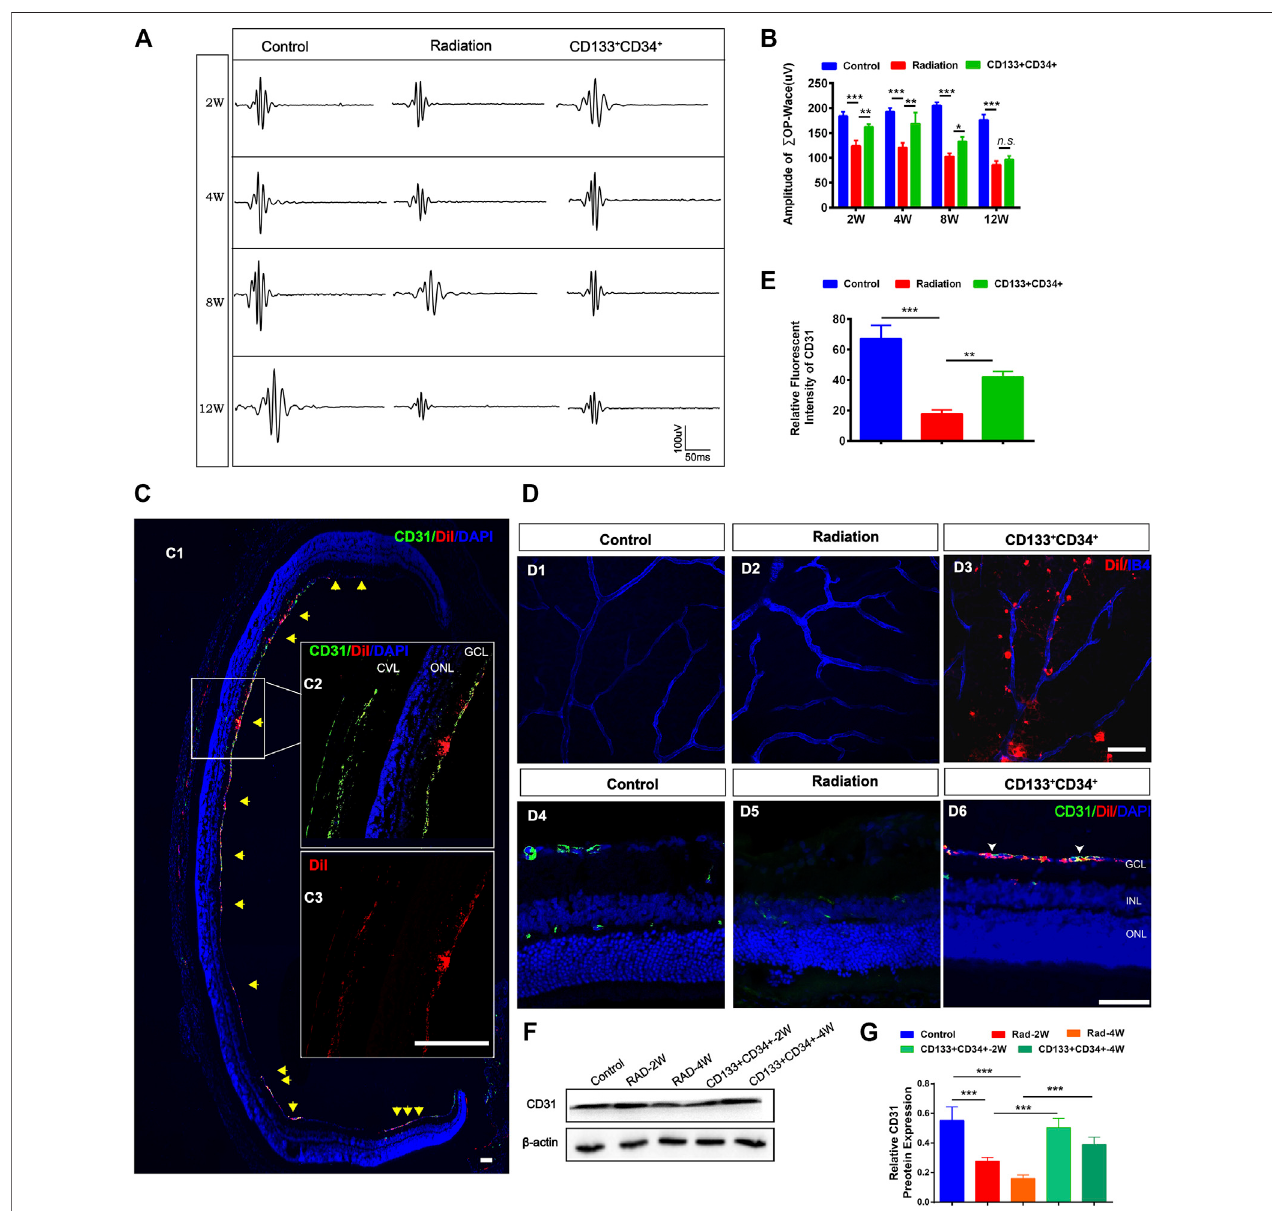
FIGURE4| TransplantedCD133 + CD34 + cellsprotectretinalvasculatureinjuriesafterradiation. (A) :RepresentativeimagesofOPswavesoffERGbetweencontrol, irradiated, and cell transplanted group. (B) : The statistics of (cid:1) OPs wave amplitude from 2 to 12 weeks. (C) : Intravitreous transplantation of CD133 + CD34 + cells in X-irradiated rats. C1: The distribution of the transplanted CD133 + CD34 + cells in retinal section Discussion week-transplantation later; Scale bar: 50 μ m. C2: The magni fi cation oftheretinal section. C3: Individual channel ofDil labeled CD133 + CD34 + cells.Scale bar: 50 μ m. (D) :D1-D6: ThedistributionofCD133 + CD34 + cells in the wholemount retina and retinal section after 4-week transplantation. (E) : CD31 fl uorescence intensity statistics at 4 weeks. (F) : WB analysis of the CD31 protein expressionaftertransplantationat2and4 weeks. (G) :ThestatisticsoftherelativeCD31proteinexpressionintheratretina.N=3.Dataaredepictedasmeans±SEM.(* p < 0.05, ** p < 0.01, *** p < 0.001, ANOVA-test). GCL: ganglion cell layer; INL: inner nuclear layer; ONL: outer nuclear layer; CVL: choroidal vascular layer.